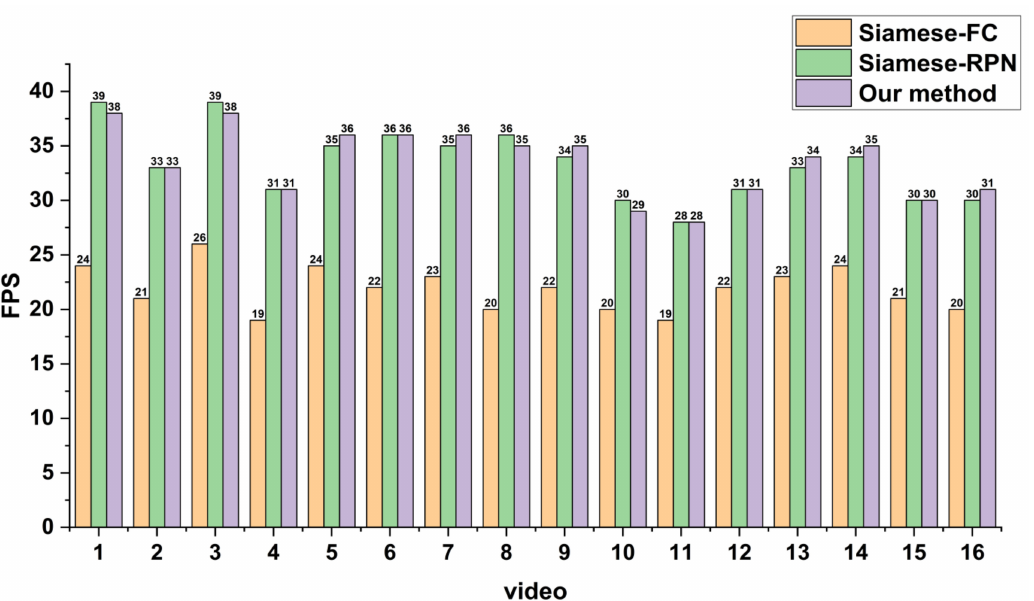
Figure 21. FPS comparison of the three